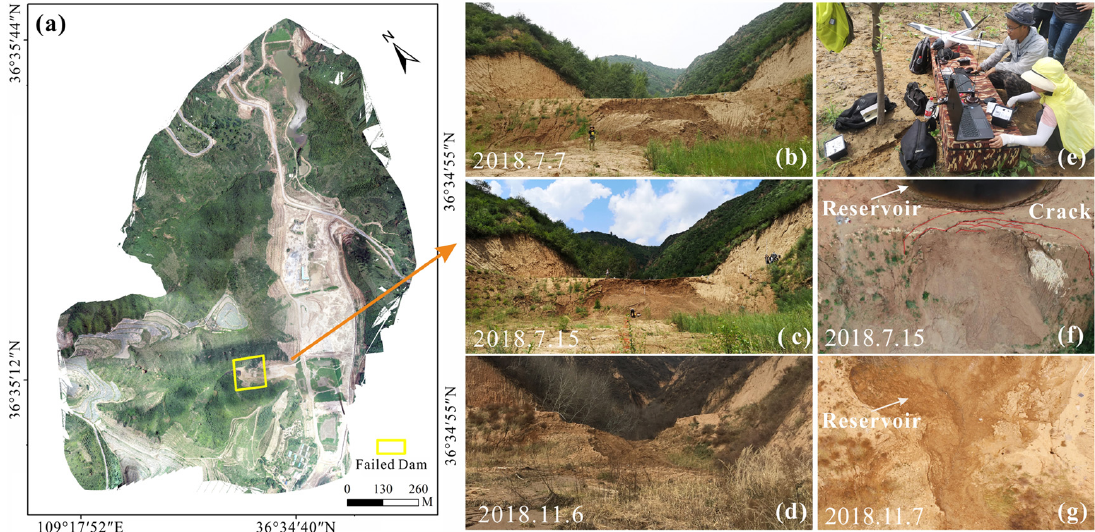
Figure 6. DOM and site pictures of a typical failed dam case. ( a ) DOM of the failed dam area obtained by UAV photogrammetry; ( b – d ) photos downstream of the dam at different times; ( e ) field work photos of UAV photogrammetry; ( f ) top view of the silt dam on 15 July 2018; ( g ) top view of the silt dam on 7 November 2018.